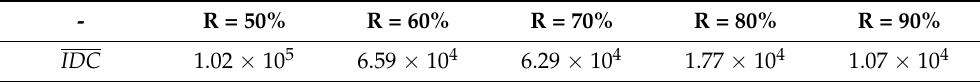
Table 2. Average Inertial drag coefficient of different pre-reductions.